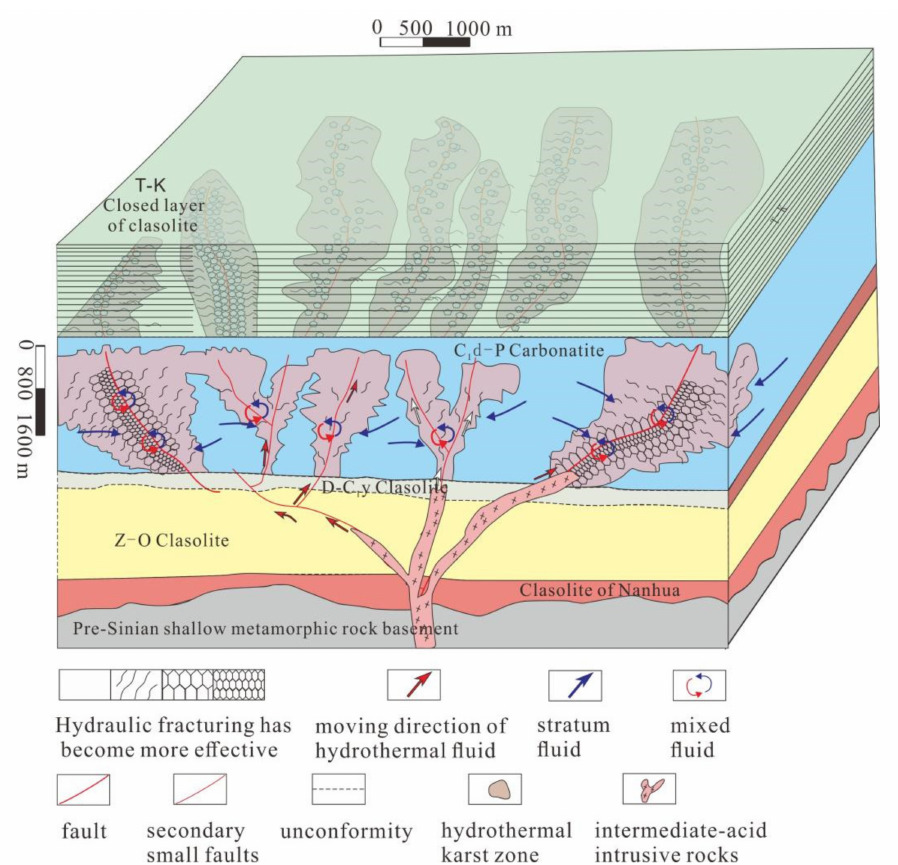
Figure 11. Fault and magmatic hydrothermal activity induced by Yanshanian tectonic activity in Huanjiang